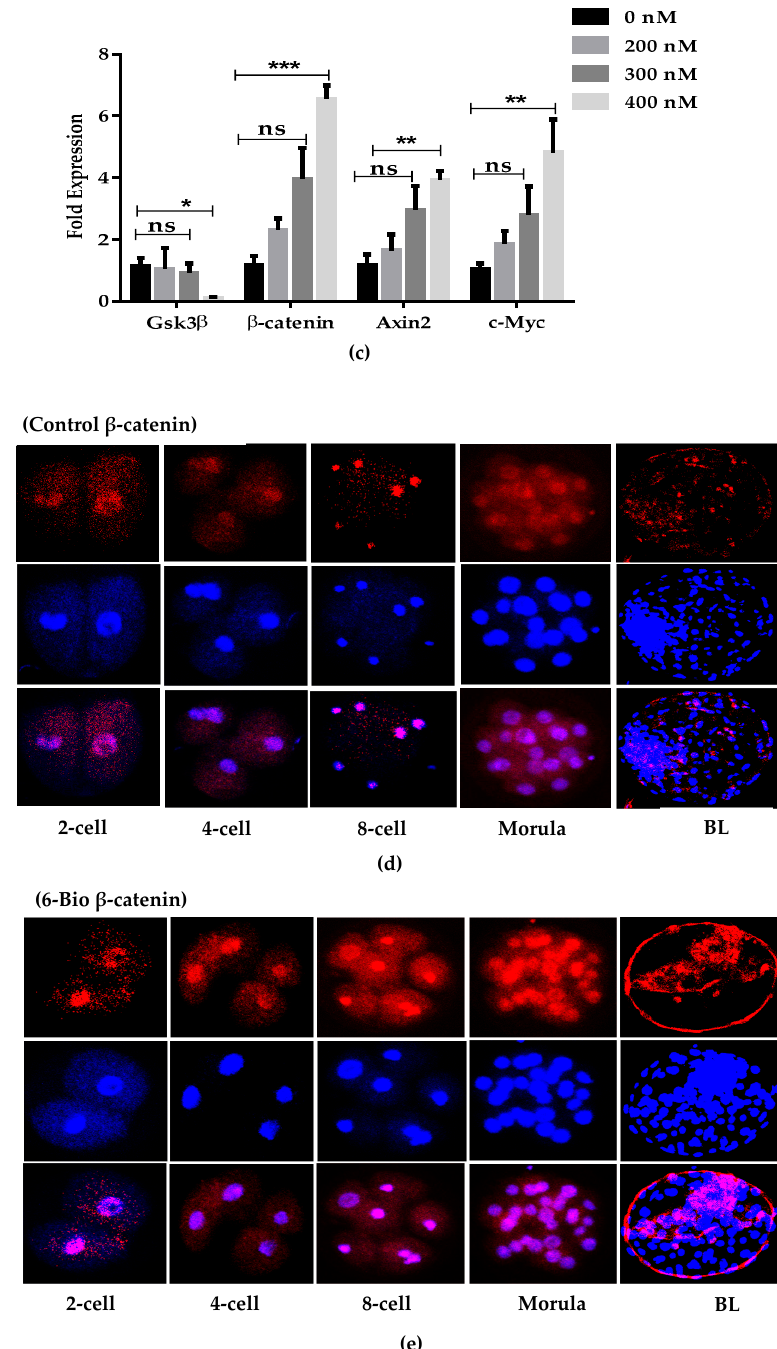
Figure 1. E ff ect of 400 nM dose of 6-Bio treatment on Wnt-directed genes expression and bovine embryonic development. ( a – b ) Representative bar graph showing the % of BLs development and hatching rate after addition of di ff erent concentrations of Wnt agonist 6-Bio. Data are presented as a result of ± standard error of mean (SEM) of 8 replicates. ( c ) qRT-PCR analysis of the expression profile of several Wnt components in response to the indicated concentrations of 6-Bio treatments. ( d – e ) Immunofluorescence analysis showing the expression of activated β -catenin in control versus 6-Bio treated group during pre-implantation stages. DAPI staining (blue; all nuclei). * p < 0.05; ** p < 0.01; *** p < 0.001 indicates significant di ff erence. Original magnification 100 ×